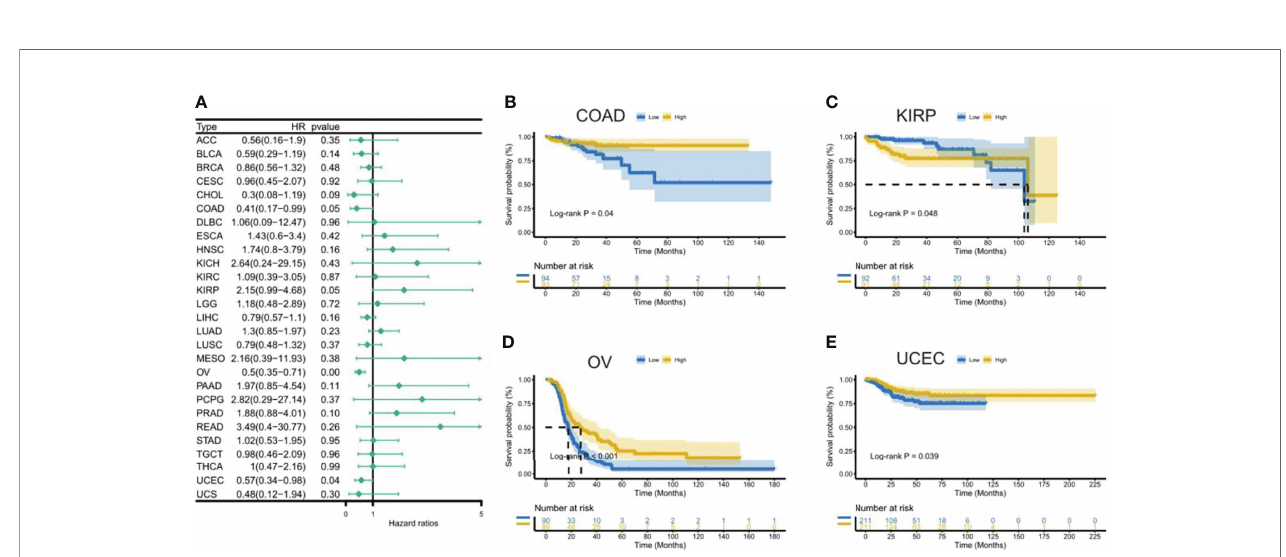
FIGURE 5 | Association between CXCL11 expression and disease-free interval (DFI). (A) Forest plot of DFI association with CXCL11 expression across cancers. (B – E) Kaplan – Meier analysis of the association between CXCL11 expression and DFI in COAD, KIRP, OV, and